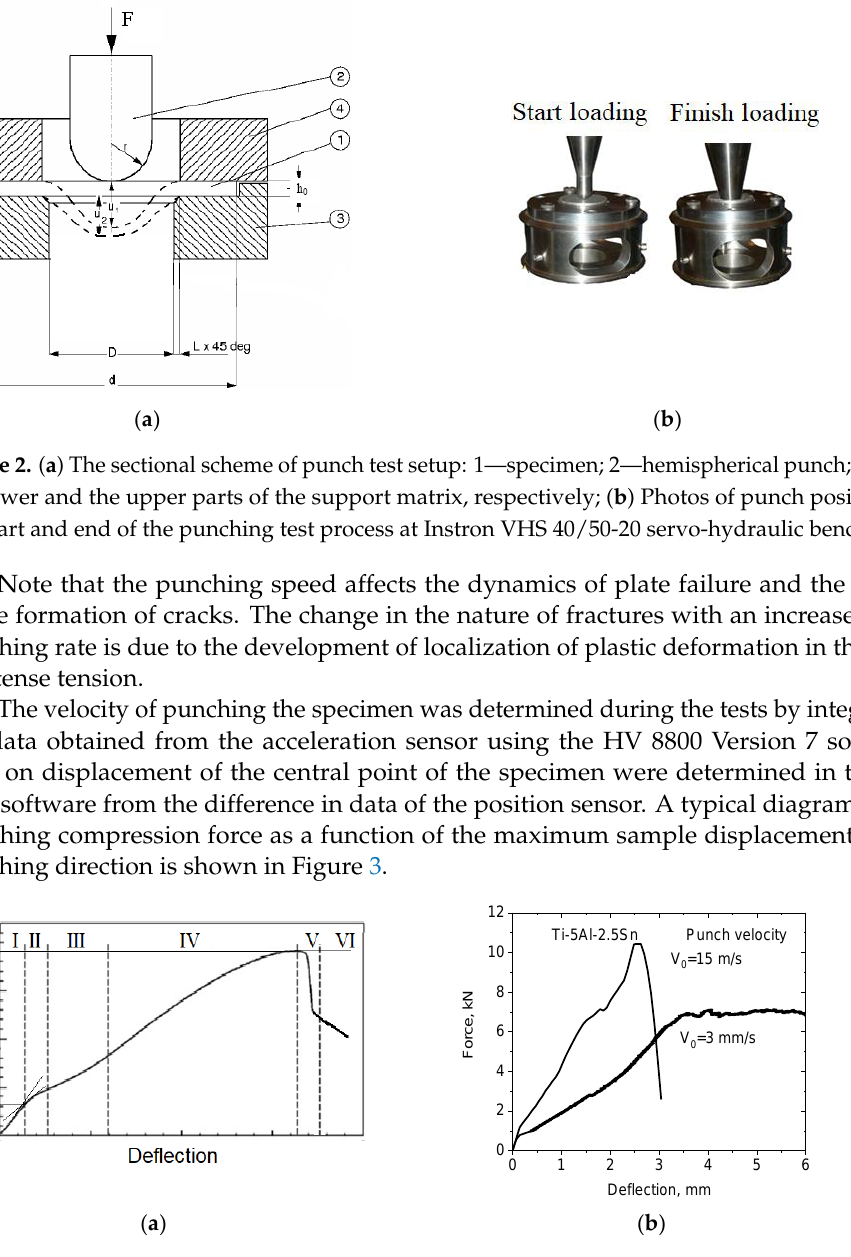
Figure 3. ( a ) Diagram of punching force versus the maximum displacement of the specimen; ( b ) Experimental F( u z ) diagram for Ti-5Al-2.5Sn. Six stages can be distinguished on the F( u z ) diagram